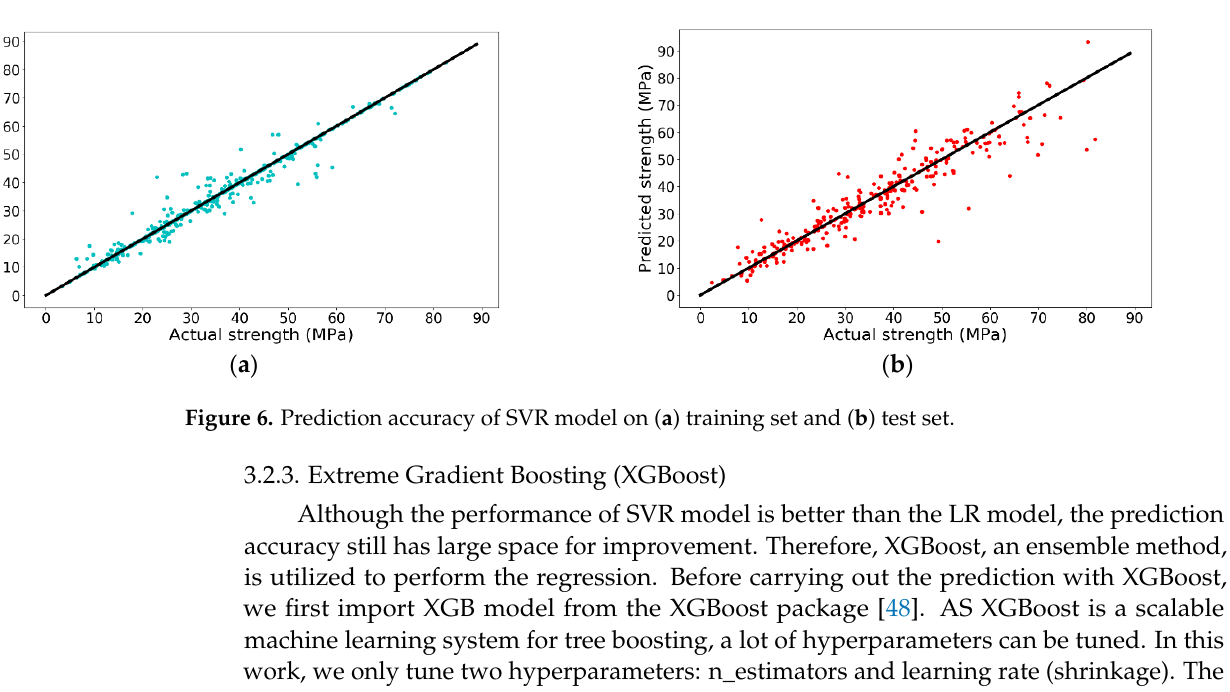
Figure 5. R-square of SVR under different hyperparameters C and γ on ( a ) training set and ( b ) test set.